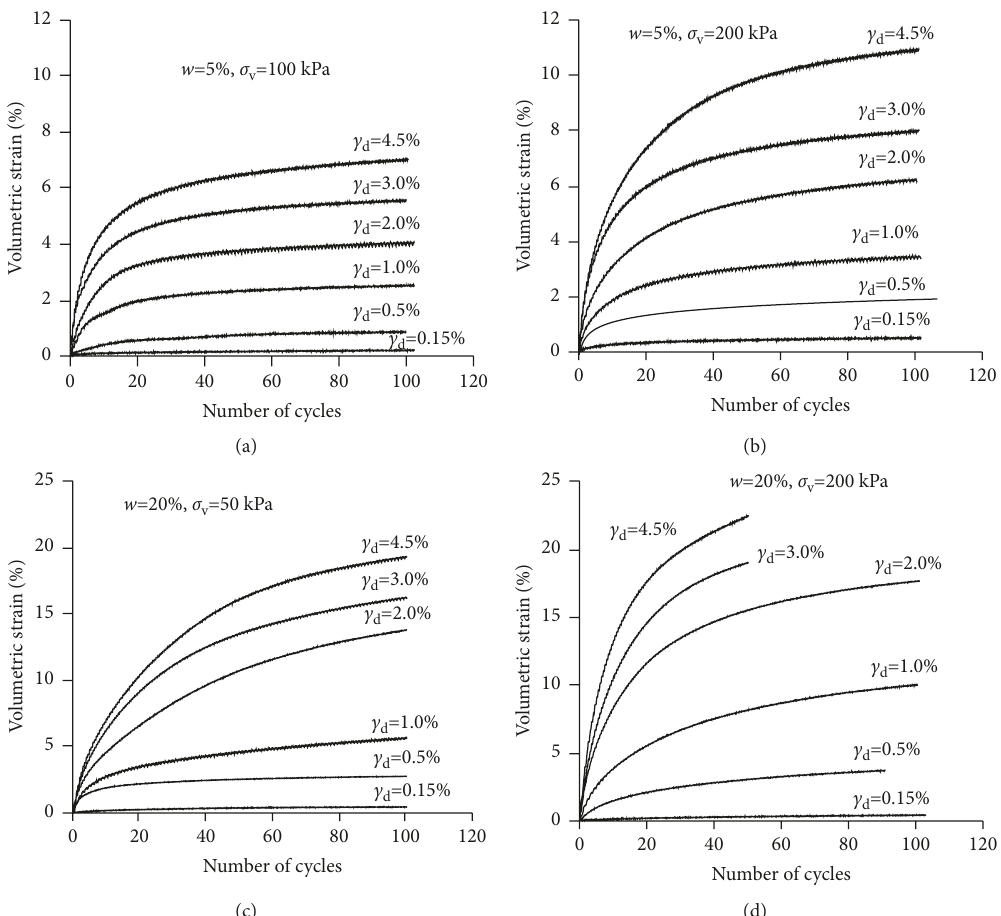
Figure 4: Comparison between the volumetric strain time histories under different amplitudes of shear strain (here, w is water content, σv is vertical stress, and c d is the amplitude of shear